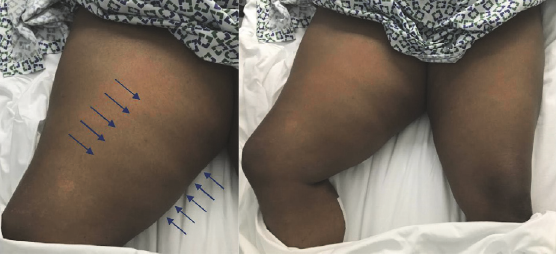
Figure 1: Diabetic myonecrosis involving the right thigh with overlying palpable skin induration (arrows). Enlargement of right thigh compared to left. Right leg was kept externally rotated.